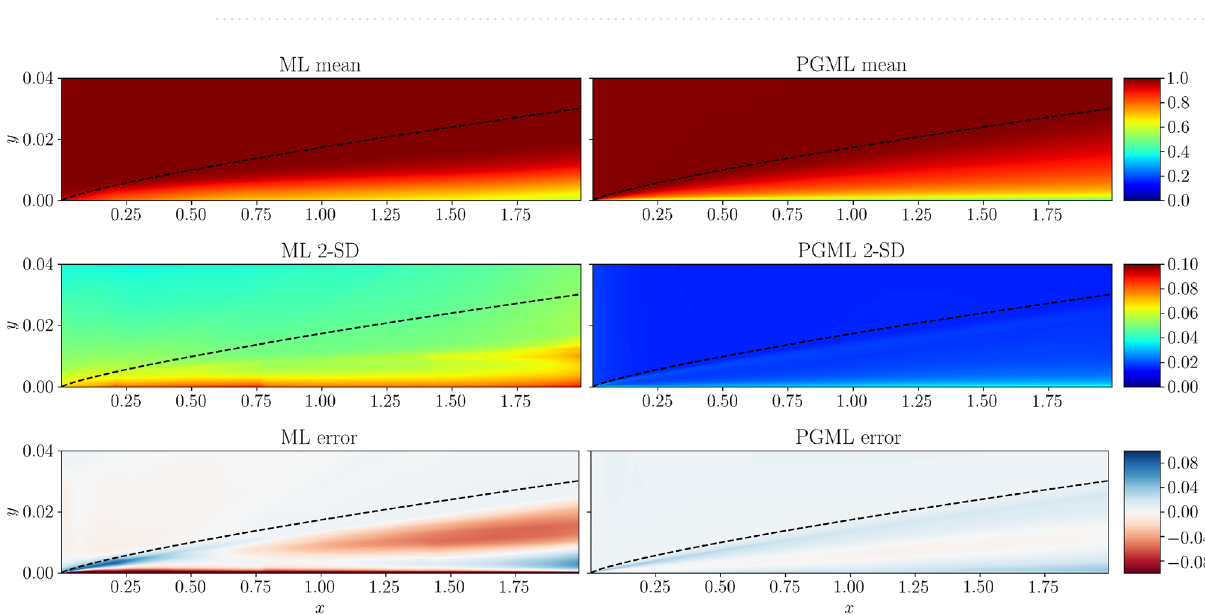
Figure 6. Prediction of the turbulent flat plate boundary layer with 5% of data used for training the ML and PGML model. The error is calculated as the difference between the true flow field and the flow field predicted by ML and PGML models. The figure is created by Matplotlib v3.5.1 50